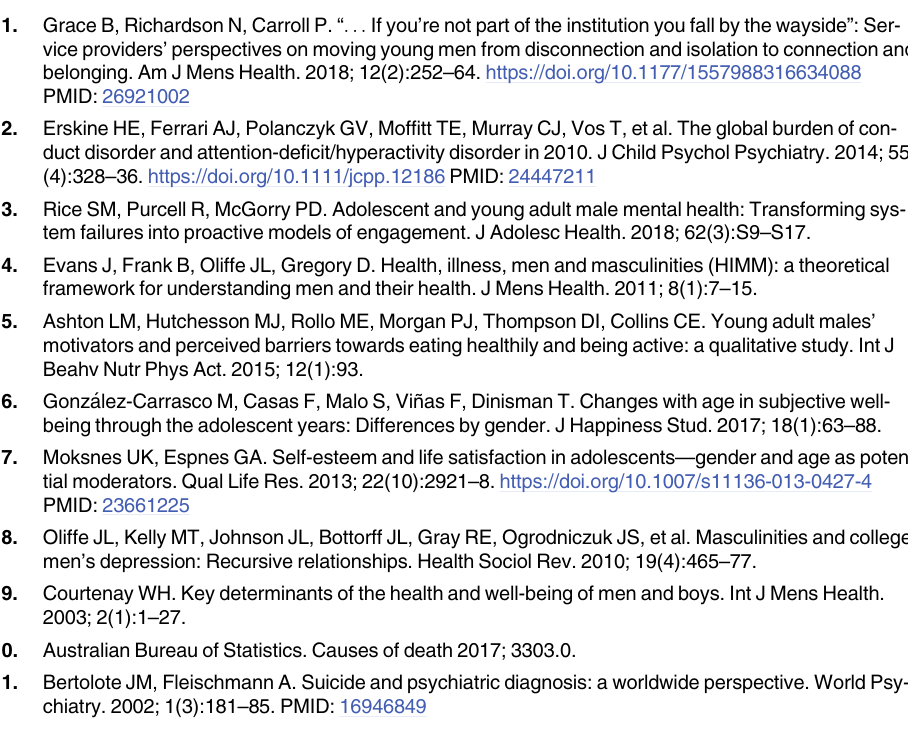
S2 Table. Article results